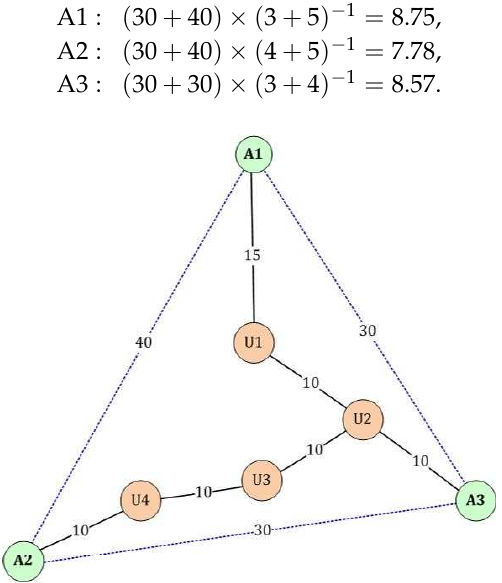
Figure 1. A diagram of the range measurement error for the distance vector hop (DV-HOP)